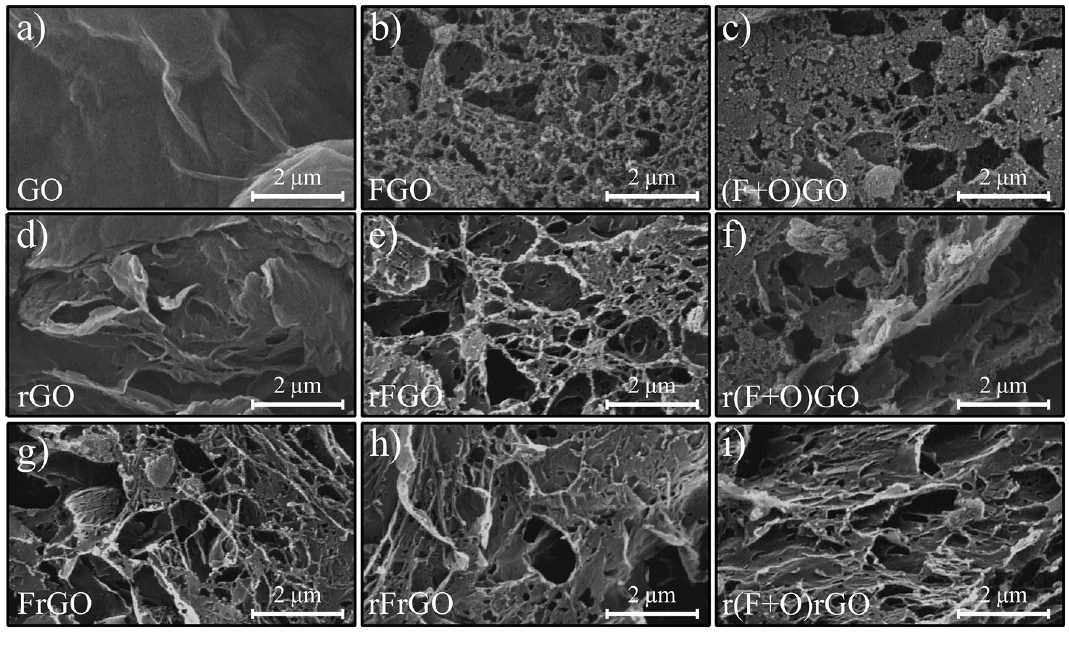
Figure 3. FE-SEM image of the ( a ) pristine GO, ( b ) FGO, ( c ) (F + O)GO, ( d ) rGO, ( e ) rFGO, ( f ) r(F + G)GO, ( g ) FrGO, ( h ) rFrGO, and ( i ) r(F + O)rGO samples.